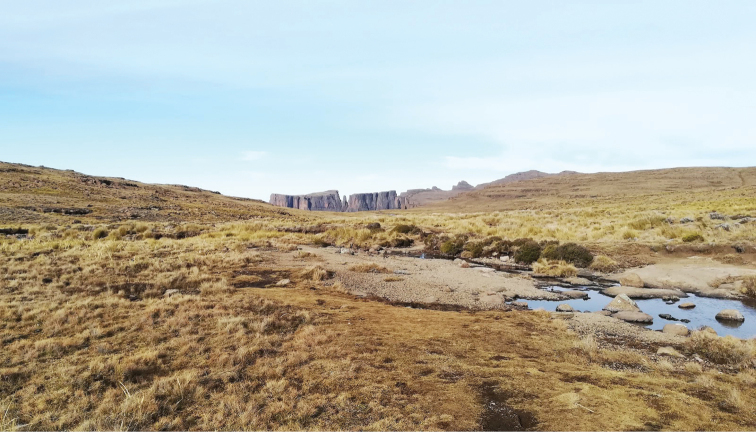
River nr Sentinel Peak, 2960 m, Drakensberg, KwaZulu-Natal, South Africa. Locality for Agabus
austellus sp. nov. May 28, 2018. Photo Samuel Motitsoe.